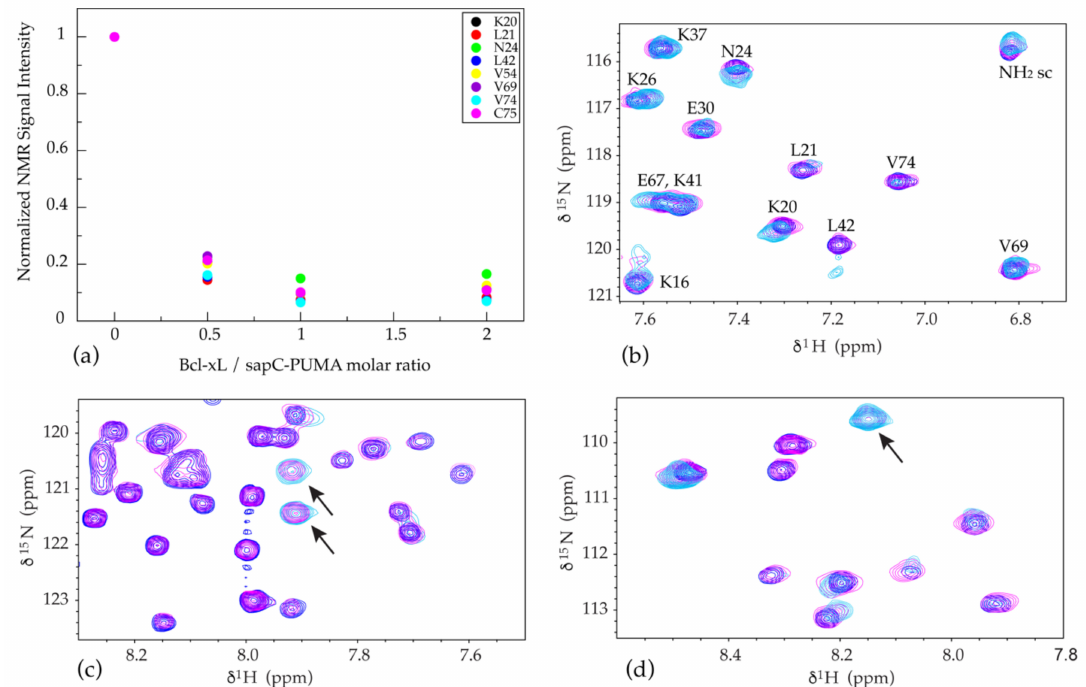
Figure 8. SapC-PUMA binds Bcl-xL via PUMA BH3 domain: ( a ) Decrease of NMR signal intensity for selected amino acids (indicated in the inset) of the sapC domain in sapC-PUMA as Bcl-xL/sapC-PUMA molar ratio increases. ( b – d ) Selected regions of overlaid [ 1 H, 15 N]-2D NMR spectra of 15 N-labeled sapC-PUMA at Bcl-xL/sapC-PUMA molar ratios; 0:1 (blue), 0.5:1 (magenta) and 1:1 (cyan). SapC signals labeled with the corresponding amino acids are minimally perturbed in ( b ). New signals for the PUMA domain, indicated with arrows in ( c , d ) are observed at Bcl-xL/sapC-PUMA molar ratios 0.5:1 and